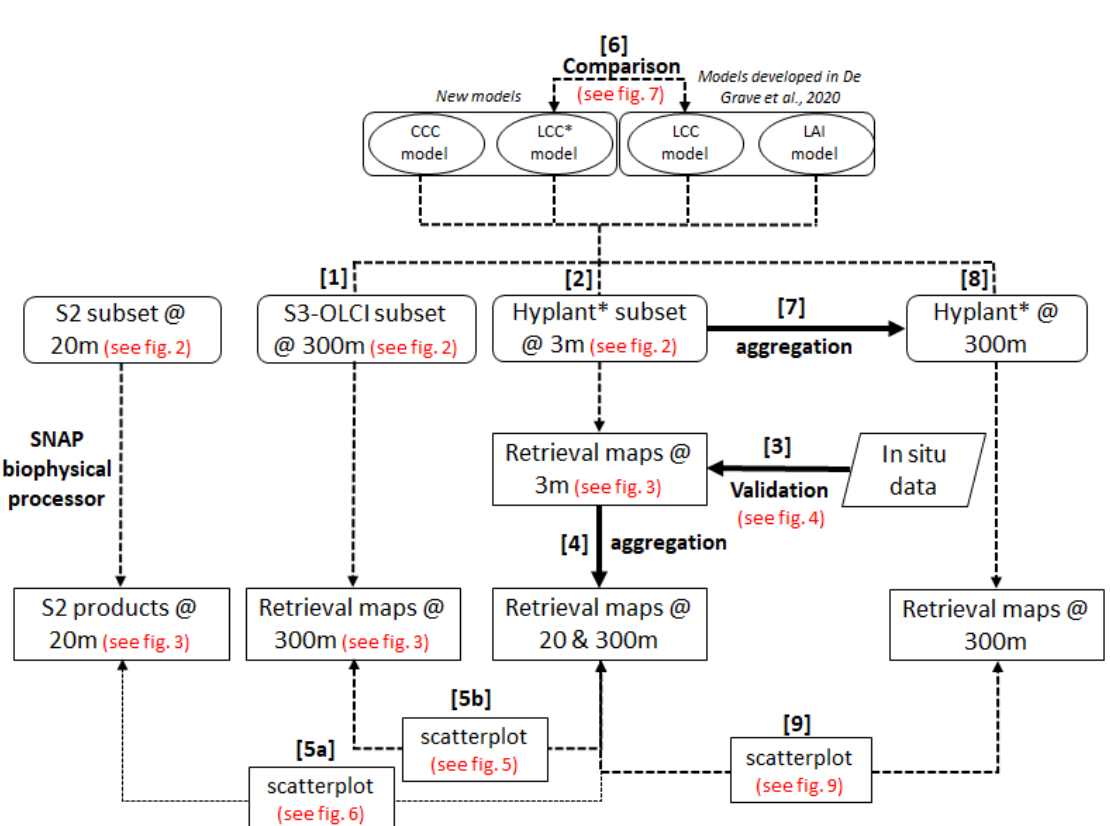
Figure 1. Schematic workflow of the presented methodology for the study of the retrieval of chlorophyll (Chl) content at moderate resolution. The development of the leaf chlorophyll content (LCC) and leaf area index (LAI) retrieval models is described in [19]. Two models were newly developed in the present study: the canopy chlorophyll content (CCC) model, by multiplying LCC and LAI before the Gaussian process regression (GPR) training, and the LCC* model, by integrating pixel heterogeneity. Hyplant*: Hyplant DUAL data resampled at the Sentinel-3 (S3)-Ocean and Land Color Instrument (OLCI) spectral